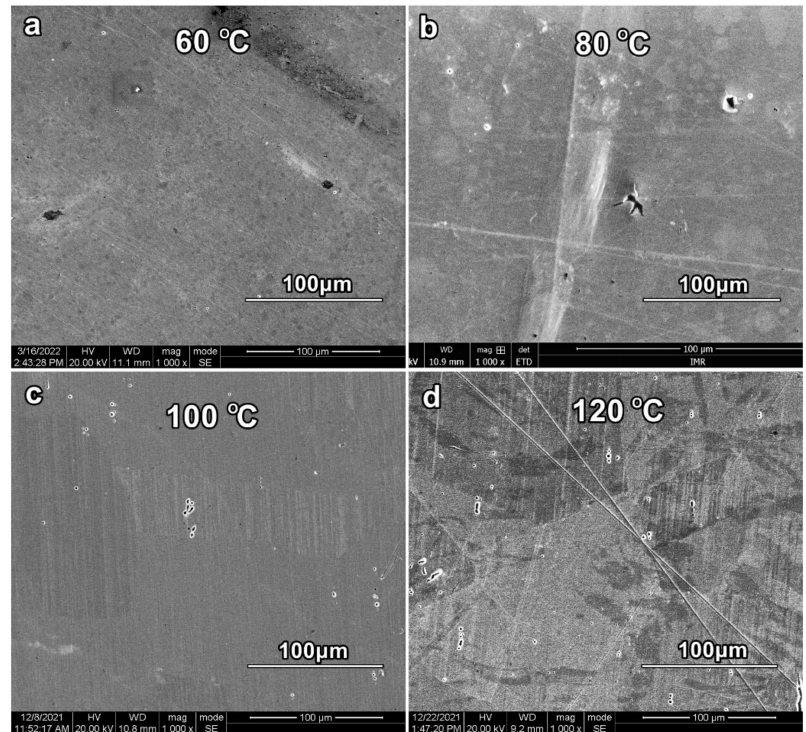
Figure 14. Morphology of SiN stainless steel corroded in condensate phase at different temperatures